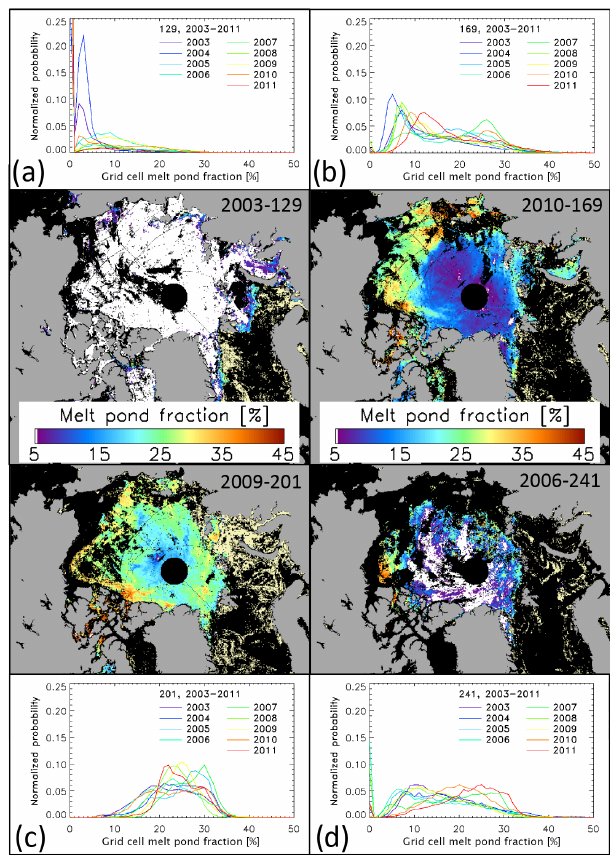
Figure 2. Sample maps of the Arctic melt pond fraction from the MODIS data set for (a) day of year (DOY) 129 (9–16 May) 2003, (b) DOY 169 (18–25 June) 2010, (c) DOY 201 (20–27 July) 2009, and (d) DOY 241 (29 August–5 September) 2006, illustrating the conditions during pre-melt, melt advance, peak melt, and end of melt, respectively. Black denotes open water, missing (note in this context the curvilinear one-grid-cell-wide features with missing data which originate from the gridding process) or invalid data, and clouds. Melt pond fractions smaller than 5% are displayed in white. The histograms show the distribution of the melt pond fraction for the above-quoted DOY for every year of the period